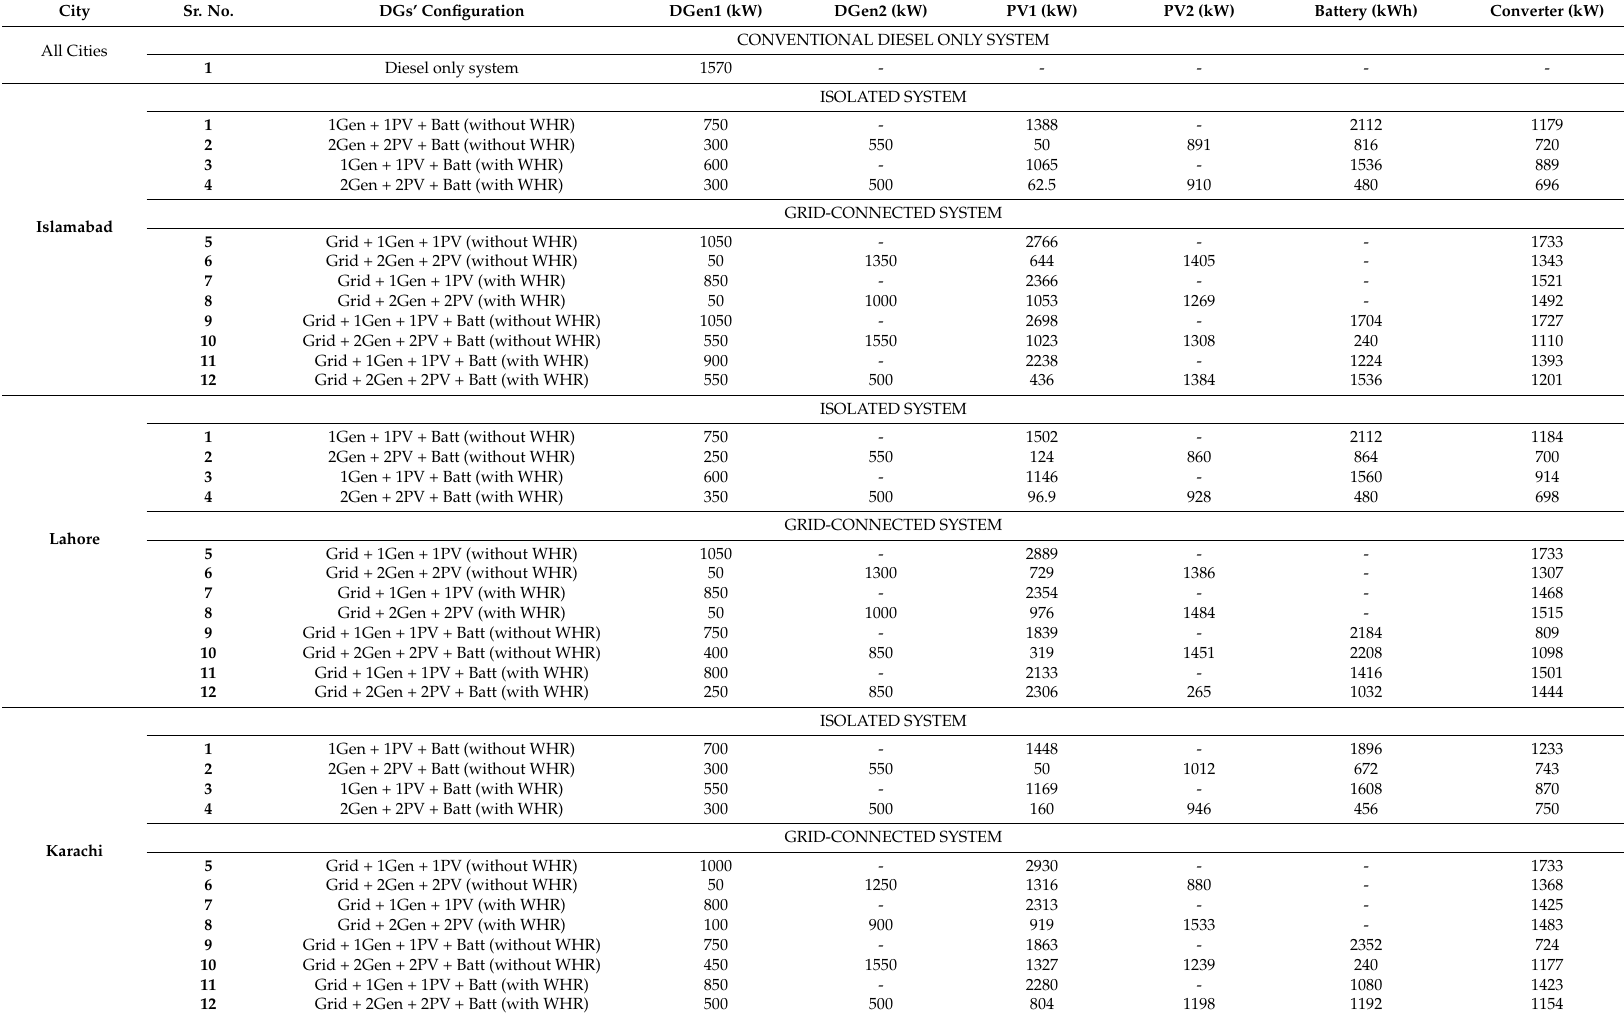
Table 4. Optimal configurations for Islamabad, Lahore and